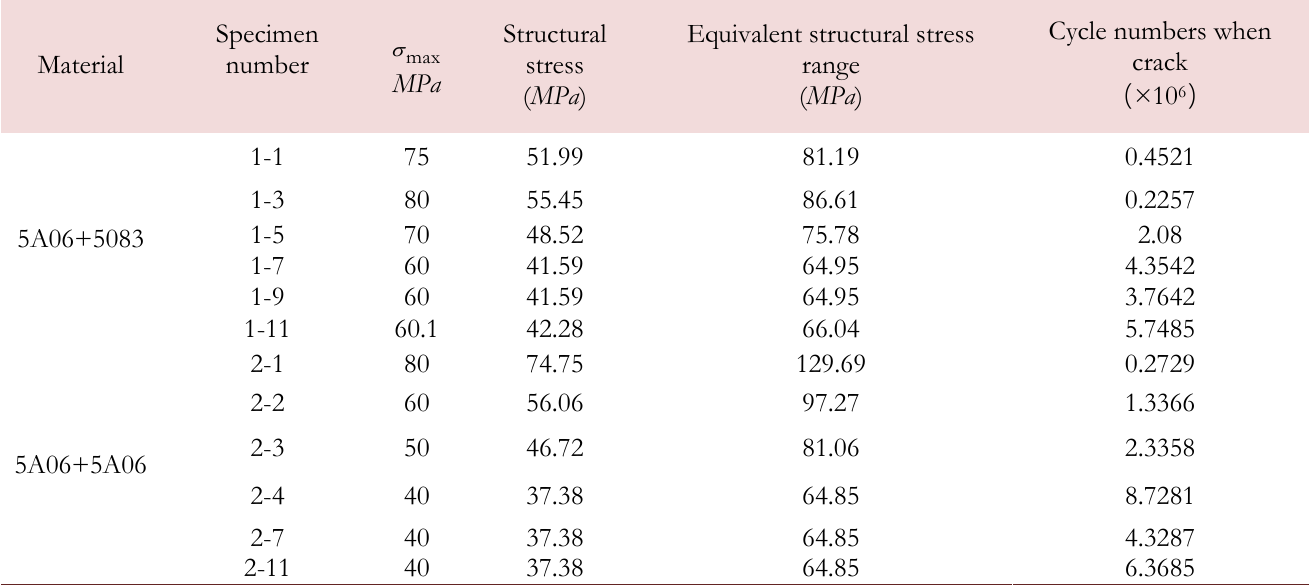
Table 8: Computation results of structural stress and equivalent structural stress